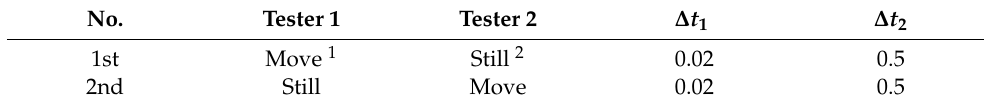
Table 1. Experimental